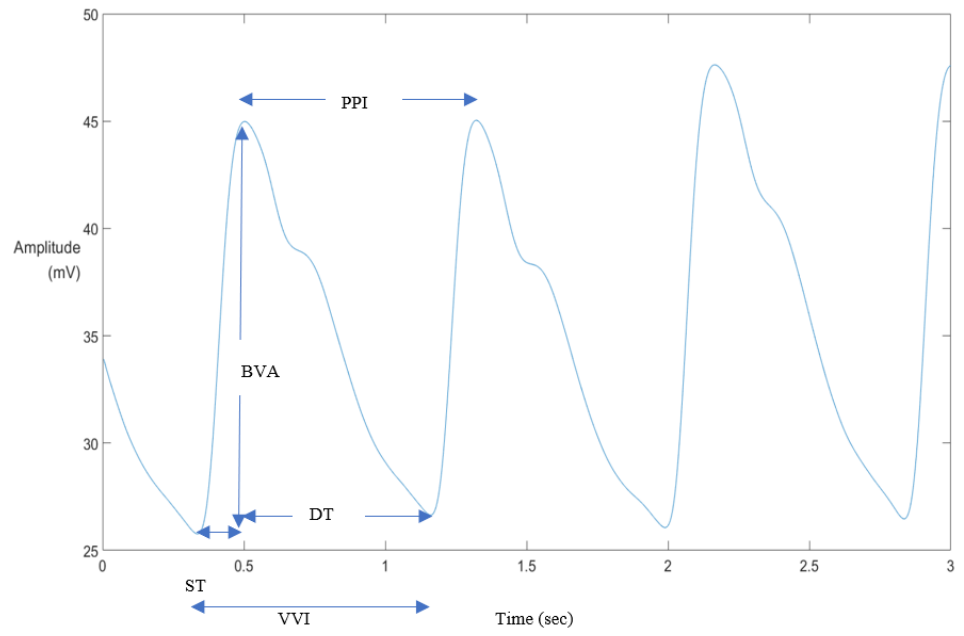
Figure 3. Significant waveform features extracted from the PPG